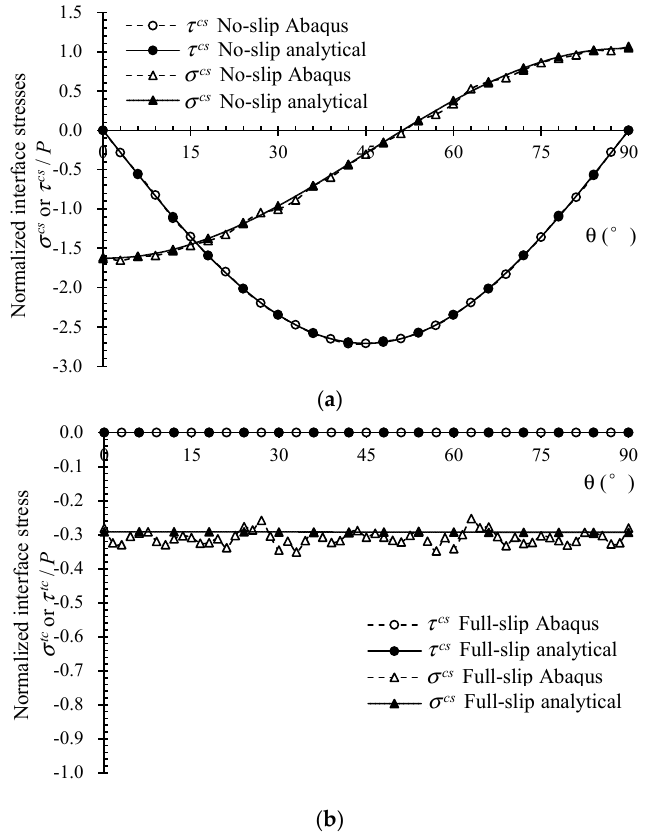
Figure 9. Comparison of the interface stresses evaluated by FE and analytical solutions with different concrete-steel interface properties. ( a ) Concrete-steel interface property: no-slip; ( b ) Concrete-steel interface property: full-slip.